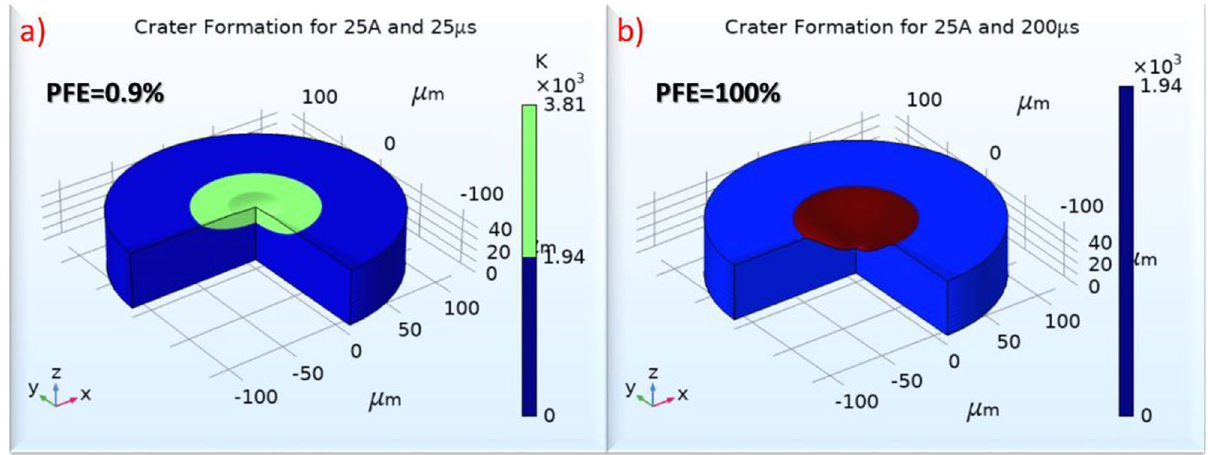
Figure 15. Craters formation for 25A and 25 μs with ( a ) PFE equals to experimental measured (0.9%), and ( b ) PFE = 100% (theoretical maximum with no WL